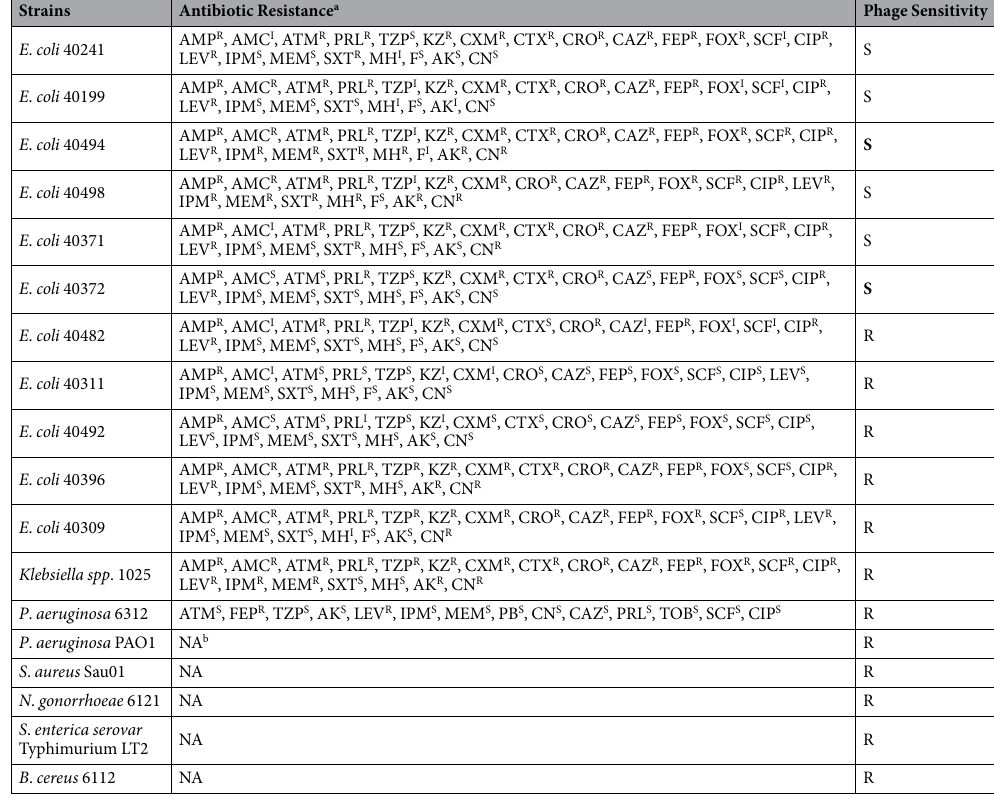
Table 1. Antibiotic resistance and phage sensitivity of strains use in this study. a R, resistant; S, susceptible; I, intermediate. AMP, Ampicillin (10 μ g); AMC, Amoxicillin-clavulanate (20/10 μ g); ATM, Aztreonam (30 μ g); PRL, Piperacillin (100 μ g); TZP, Piperacillin-tazobactam (100/10 μ g); KZ, Cefazolin (30 μ g); CXM, Cefuroxime (30 μ g); CTX, Cefotaxime (30 μ g); CRO, Ceftriaxone (30 μ g); CAZ, Ceftazidime (30 μ g); FEP, Cefepime (30 μ g); FOX, Cefoxitin (30 μ g); SCF, Cefoperazone-sulbactam (75/30 μ g); CIP, Ciprofloxacin (5 μ g); LEV, Levofloxacin (5 μ g); IPM, Imipenem (10 μ g); MEM, Meropenem (10 μ g); SXT, Trimethoprim (5 μ g); MH, Minocycline (30 μ g); F, Nitrofurantoin (300 μ g); AK, Amikacin (30 μ g); CN, Gentamicin (10 μ g); TOB, Tobramycin (10 μ g); PB, Polymyxin B (300 IU). b The data was Not